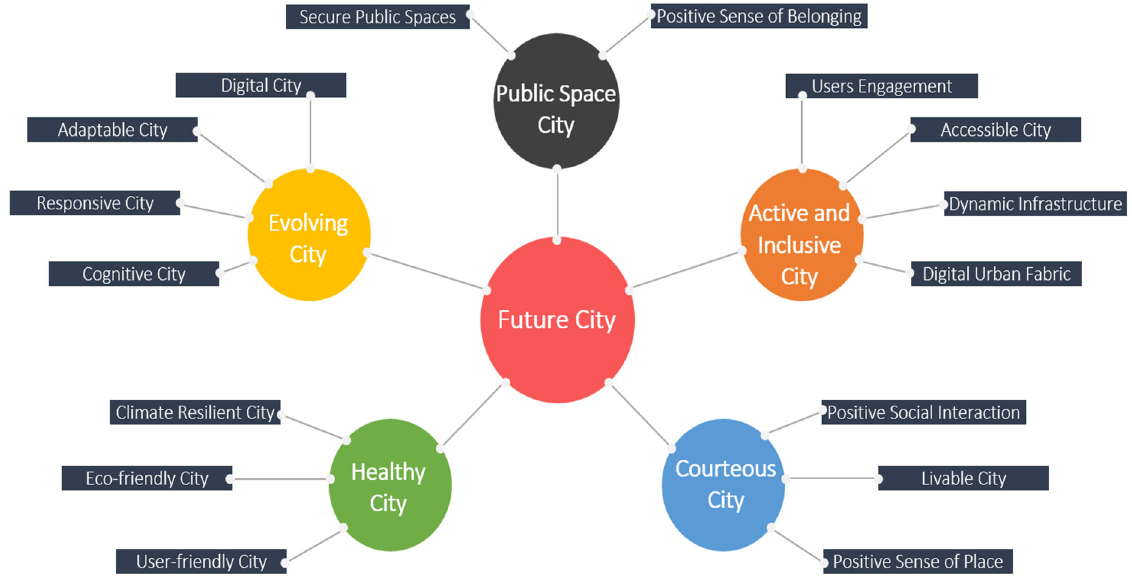
Figure 3. Future city conceptualization. Source: Authors.